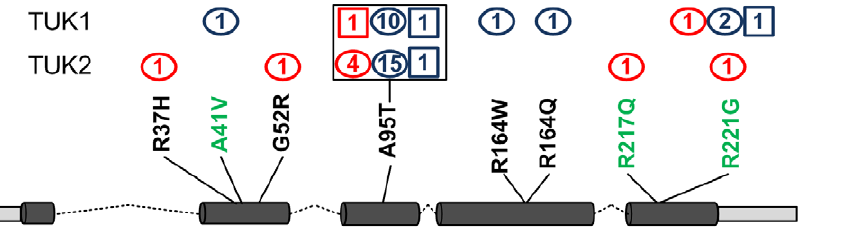
Figure 2. SNVs identified in gene GZMM . Schematic showing number of subjects in TUK1 (top row) and TUK2 (bottom row) having nonsynonymous SNVs within the GZMM gene, with novel variants in black and those described in dbSNP in green. Subject counts in blue are for pain insensitive subjects and in red, pain sensitive. Squares represent homozygous and ovals heterozygous mutations. Exons are shown as dark cylinders, UTRs pale grey rectangles and introns dotted line.